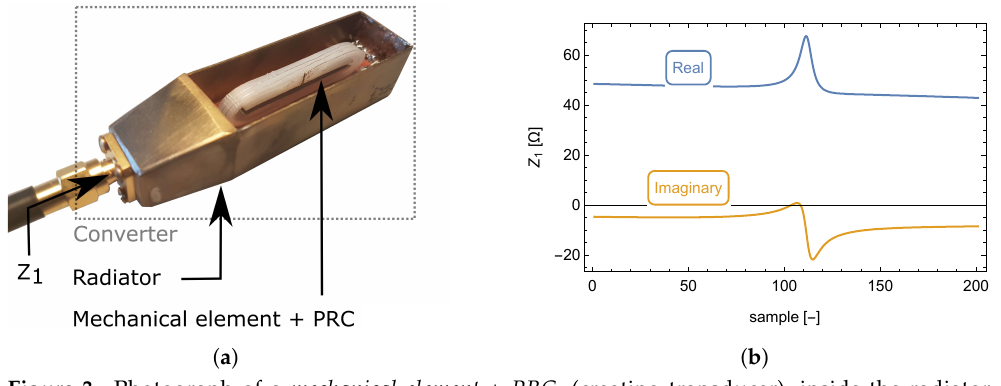
Figure 3. Photograph of a mechanical element + PRC , (creating transducer), inside the radiator (creating converter as a whole) ( a ). converter input impedance Z 1 , as function of normalized frequency (see Equation (2)) ( b ).